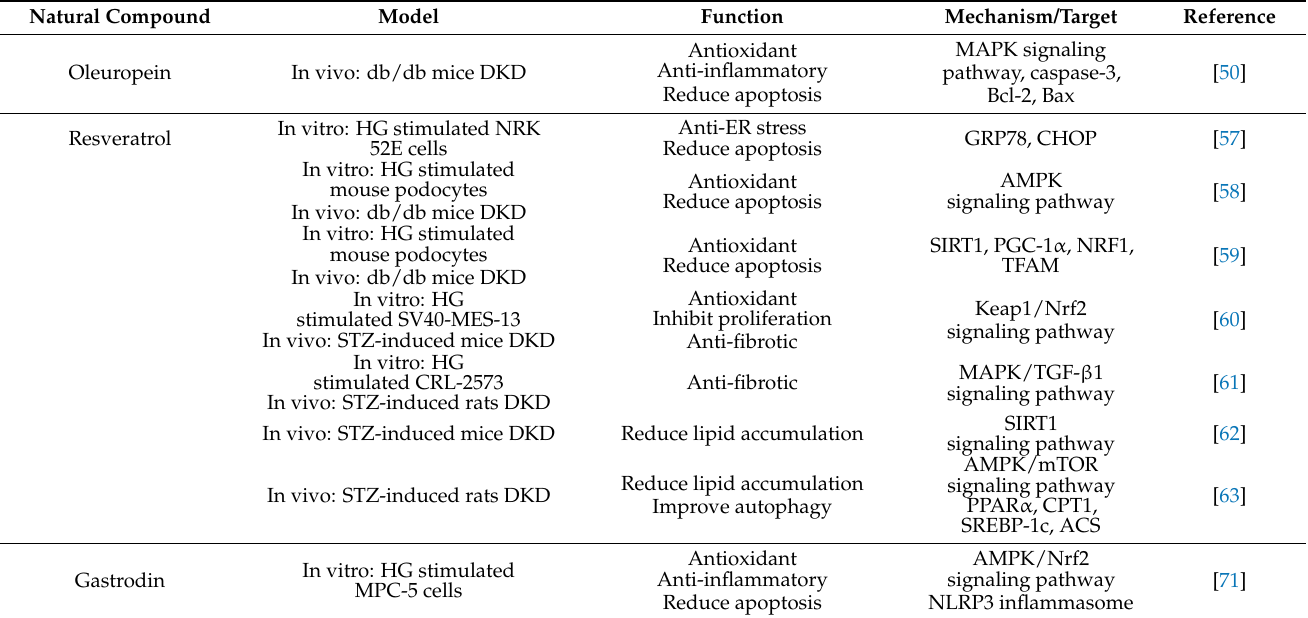
Table 1. Mechanisms of phenolics in the treatment of